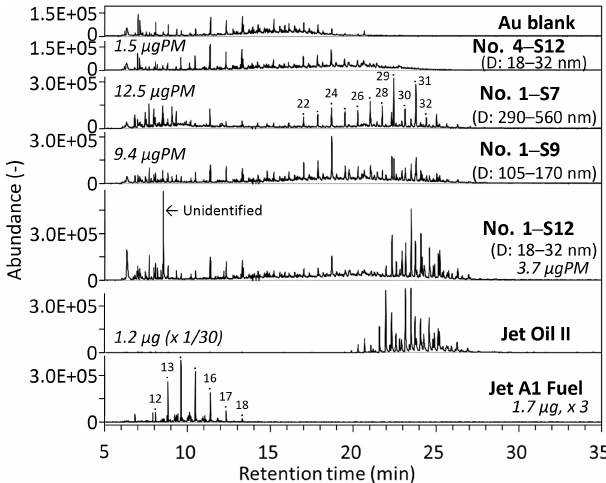
Figure 6. Mass chromatograms ( m/z 85) of size-resolved ambient particles collected during the daytime (sample no. 1, 9–13 Febru- ary 2018) and nighttime (sample no. 4, 22–26 February 2018) at the Narita International Airport. Mass chromatograms of Jet Oil II, Jet A-1 fuel, and Au-foil blank are also shown for comparison. The mass values (in micrograms) presented in the plots indicate the mass of the samples that were analyzed using TD–GC-MS. The car- bon numbers of n -alkanes are shown in the chromatograms of the S7 particles and Jet A-1 fuel.